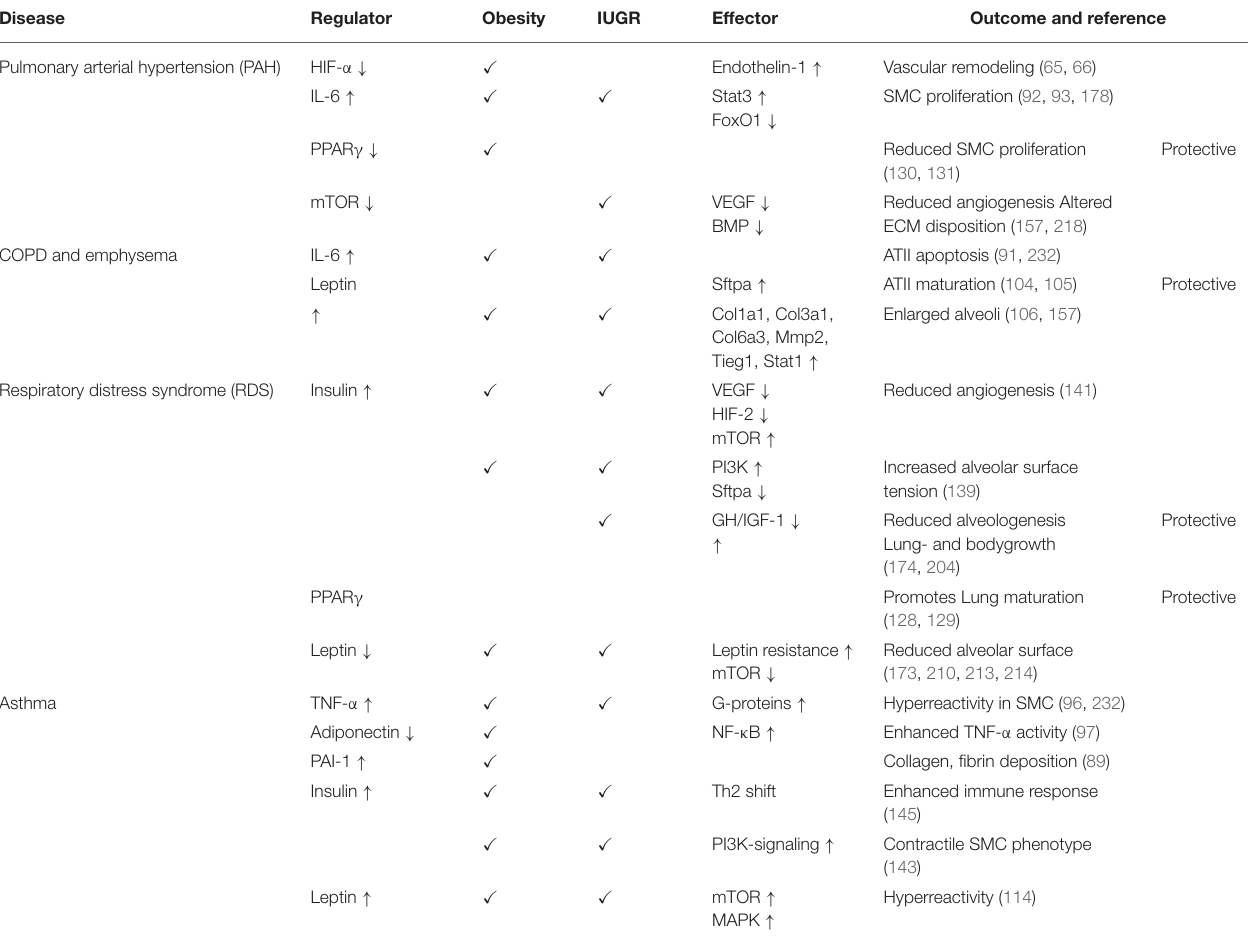
TABLE 1 | Overview of the signaling molecules and pathways involved in the perinatal nutritional and metabolic origins of chronic lung diseases.